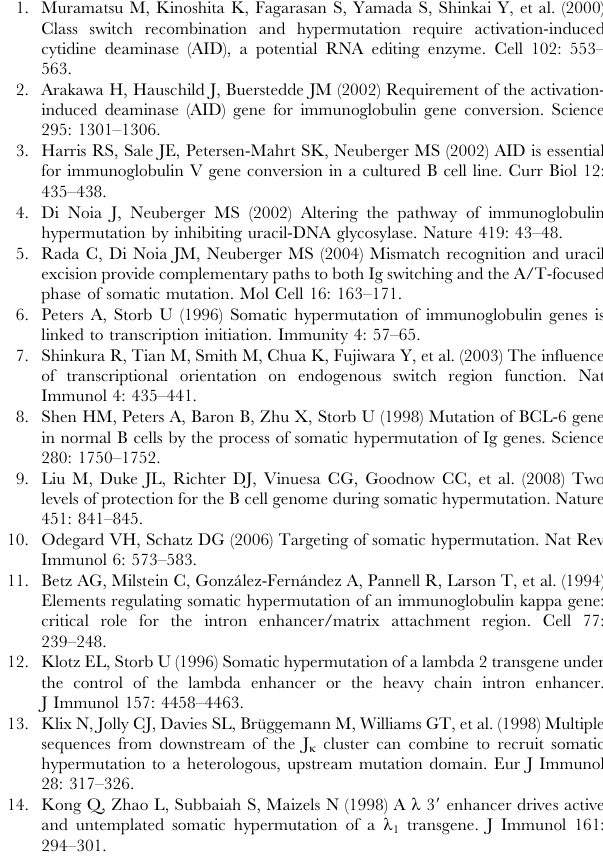
Table S2 List of